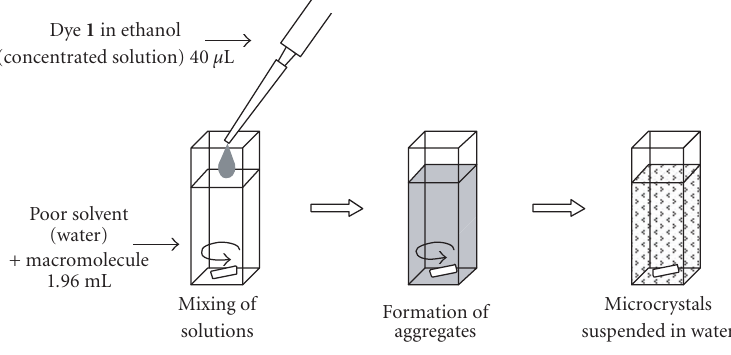
Figure 1: Schematic representation of the reprecipitation